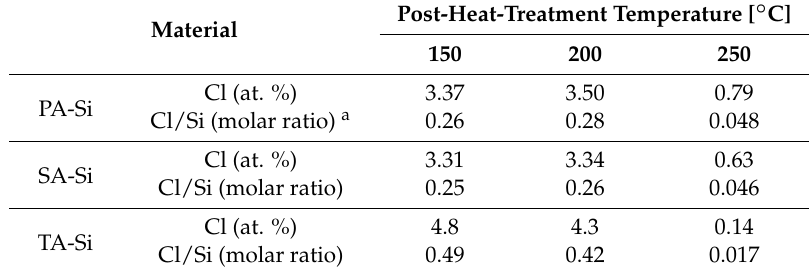
Figure 9. EDS profiles of amine-silica xerogel powders as a function of post-heat-treatment temperature (N 2 atmosphere, 30 min). Reproduced from ref. [22] with permission. Copyright (2017), Elsevier . Table 4. Residual Cl content in amine-silica xerogel powders as a function of post-heat-treatment temperature (N 2 atmosphere, 30 min). Reproduced from ref. [22] with permission. Copyright (2017), Elsevier .